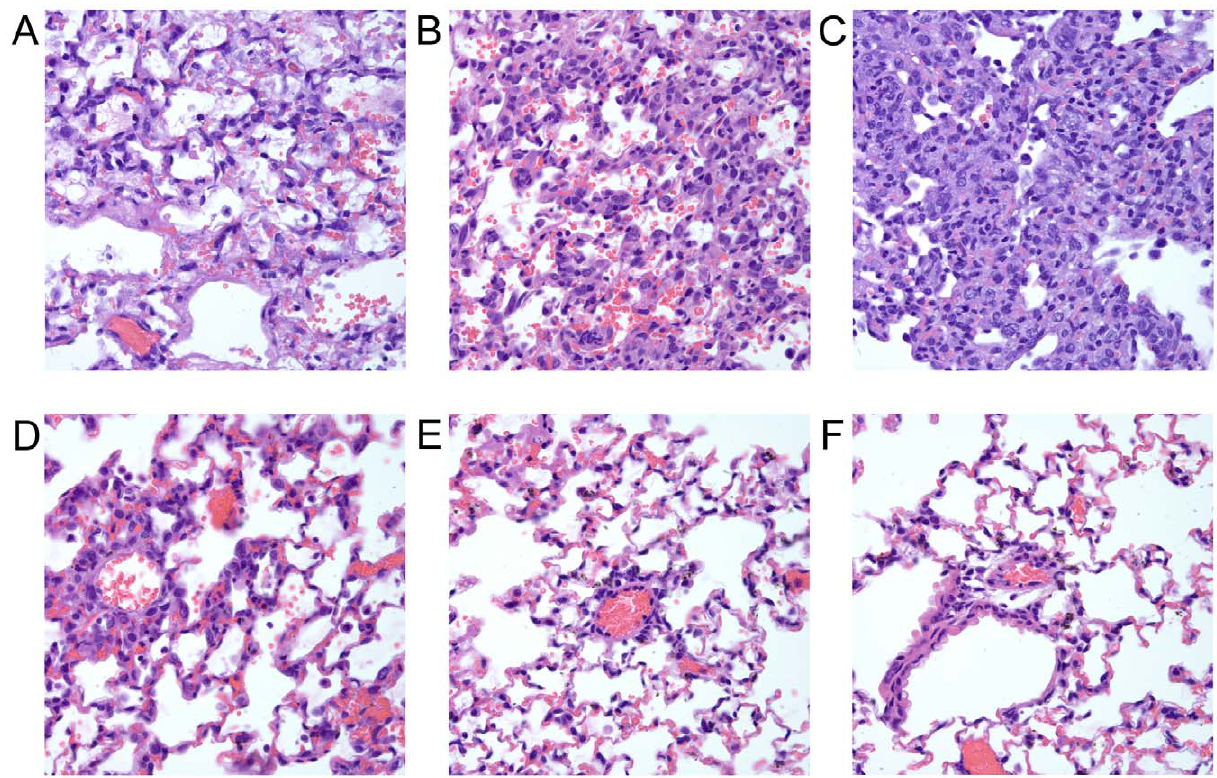
Figure 6. PB1-F2 derived peptides cause inflammation and lung pathology. Groups of mice were exposed to a panel of peptides (100 mM final concentration, see Figure 1 for definitions) and euthanized 72 hours later. Lungs were removed, sufflated, sectioned, and stained with hematoxylin and eosin for histopathologic evaluation. Representative 40 6 sections are shown from mice exposed to peptides derived from the PB1- F2 protein of A) PR8, B) H1N1 1918, C) H2N2 1957, D) H5N1 2004, E) H3N2 1995, or F) no peptide